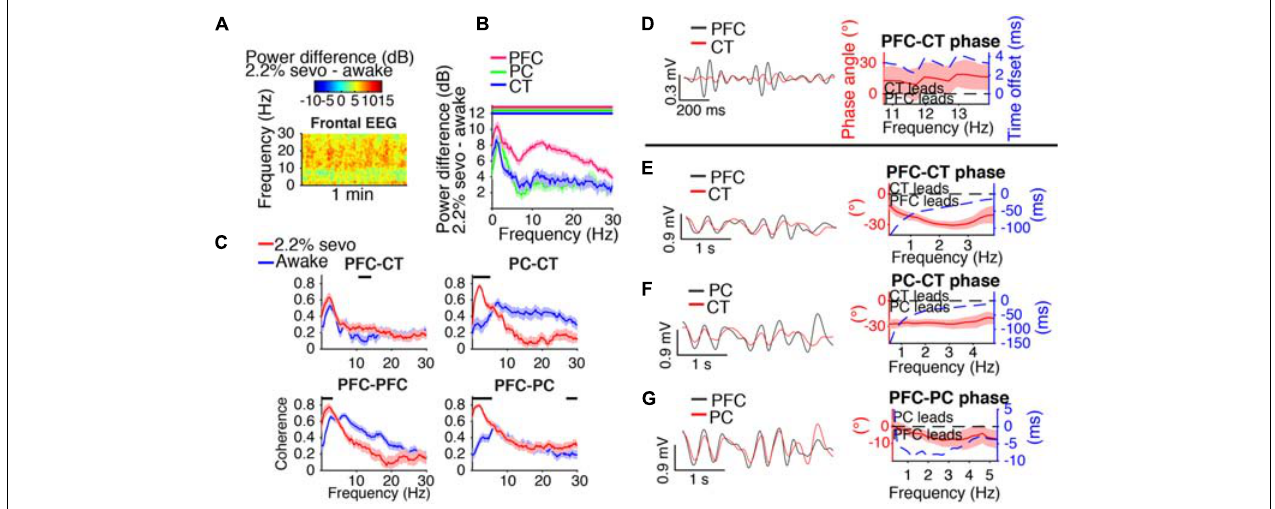
FIGURE 5 | Slow-delta dynamics during 2.2% sevoflurane. (A) Group difference spectrogram of the frontal EEG during slow-delta dominated periods at 2.2% sevoflurane. The same period is analyzed in (B–G) . (B) Group power difference between 2.2% sevoflurane and awake baseline for PFC (red), PC (green), and CT (blue) LFPs. Shading indicates 95% confidence intervals. Red, green, and blue horizontal lines mark ranges of significant power increase relative to awake baseline for PFC, PC, and CT LFPs, respectively. (C) Group coherence during the awake (blue) and 2.2% sevoflurane (red) states for pairs of LFPs. Shading indicates 95% confidence intervals, and horizontal lines mark ranges of significant coherence increase from awake baseline. (D–G) Left: LFPs from a representative animal filtered in the frequency range shown in the corresponding plot on the right. Right: Group phase relationship between two LFPs shown in terms of phase angle (left y -axis, red line) and time offset (right y -axis, blue dotted line). A positive phase relationship indicates that the first signal lags the second, and a negative phase relationship indicates that the first signal leads the second. (D) Group PFC–CT LFP phase relationship in the range of significant PFC–CT LFP coherence increase shown in (C) . (E) Group PFC–CT LFP phase relationship in the slow-delta range (note: PFC–CT coherence did not significantly increase in this range). (F) Group PC–CT LFP relationship in the range of significant PC–CT LFP coherence increase shown in (C) . (G) Group PFC–PC LFP phase relationship in the range of significant PFC–PC LFP coherence increase within the slow-delta range shown in (C) .